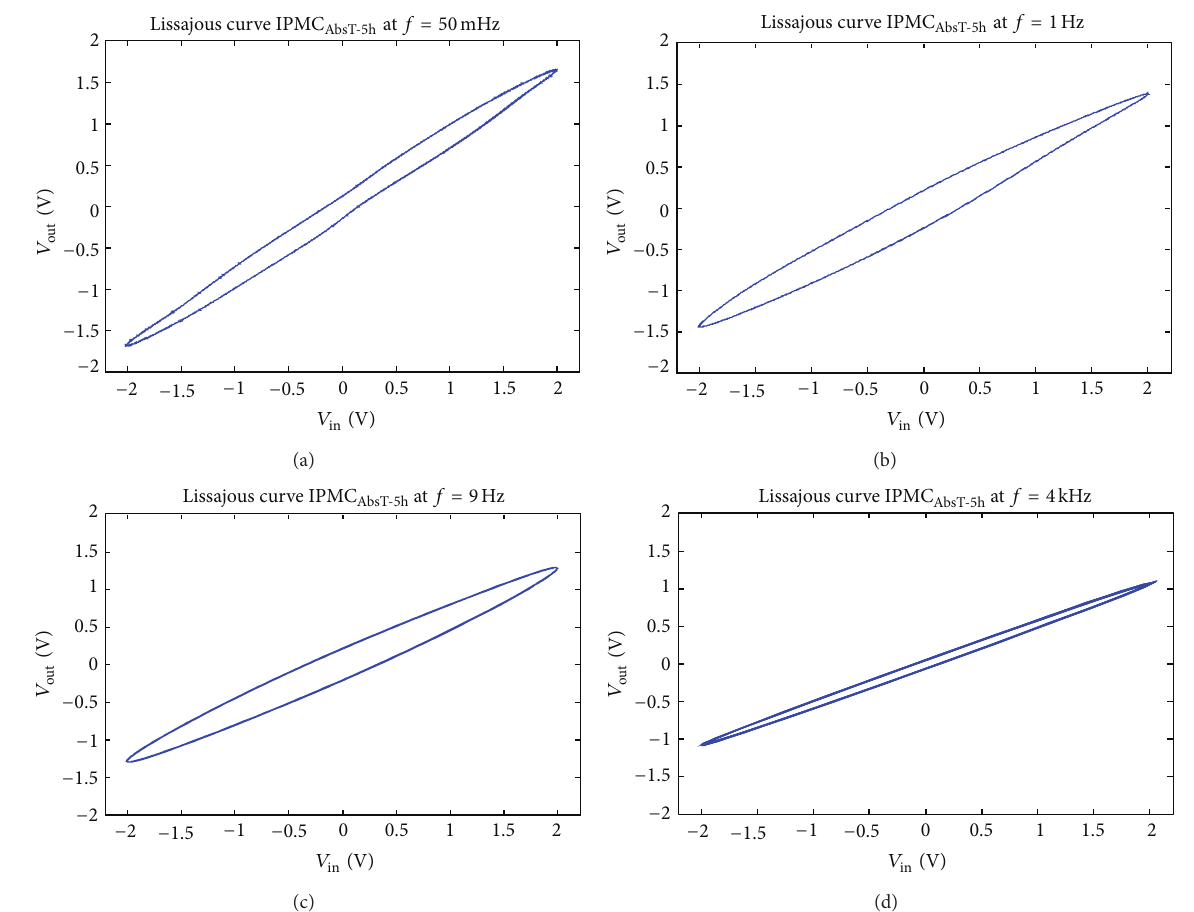
Figure 9: Shape analysis of Lissajous curves on measured input ( V in ) and output ( V out ) voltages for the device IPMC shape at 𝑓 = 50 mHz, (b) transition between nonelliptic and elliptic shapes at 𝑓 = 1 Hz, (c) elliptic shape at 𝑓 = 9 Hz, (d) elliptic shape at 𝑓 = 4 kHz.